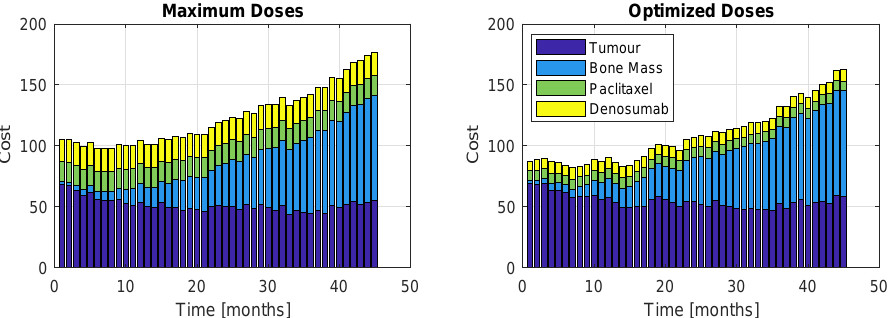
Figure 11. Proportions of the four cost contributions/terms in the objective function: Tumour, Bone Mass, Paclitaxel and Denosumab (Model M DR 1 , Therapy T 1 + T 3 ). The right plot represents the cost resultant from optimization, while the left represents the cost if the maximum dose was administrated.